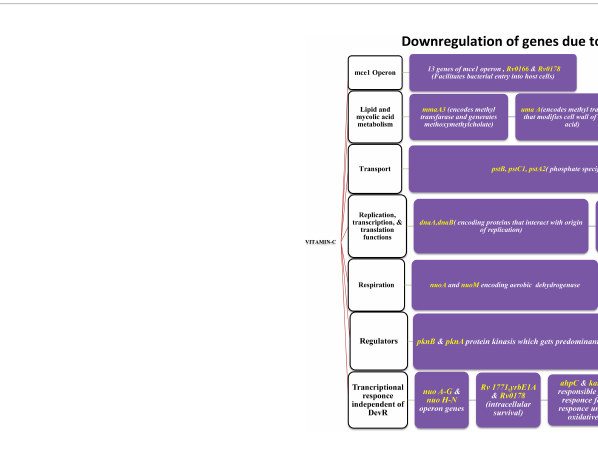
FIGURE 4 Antibiotic targeting sites (mode of action of antibiotics) and the mechanism of resistance towards